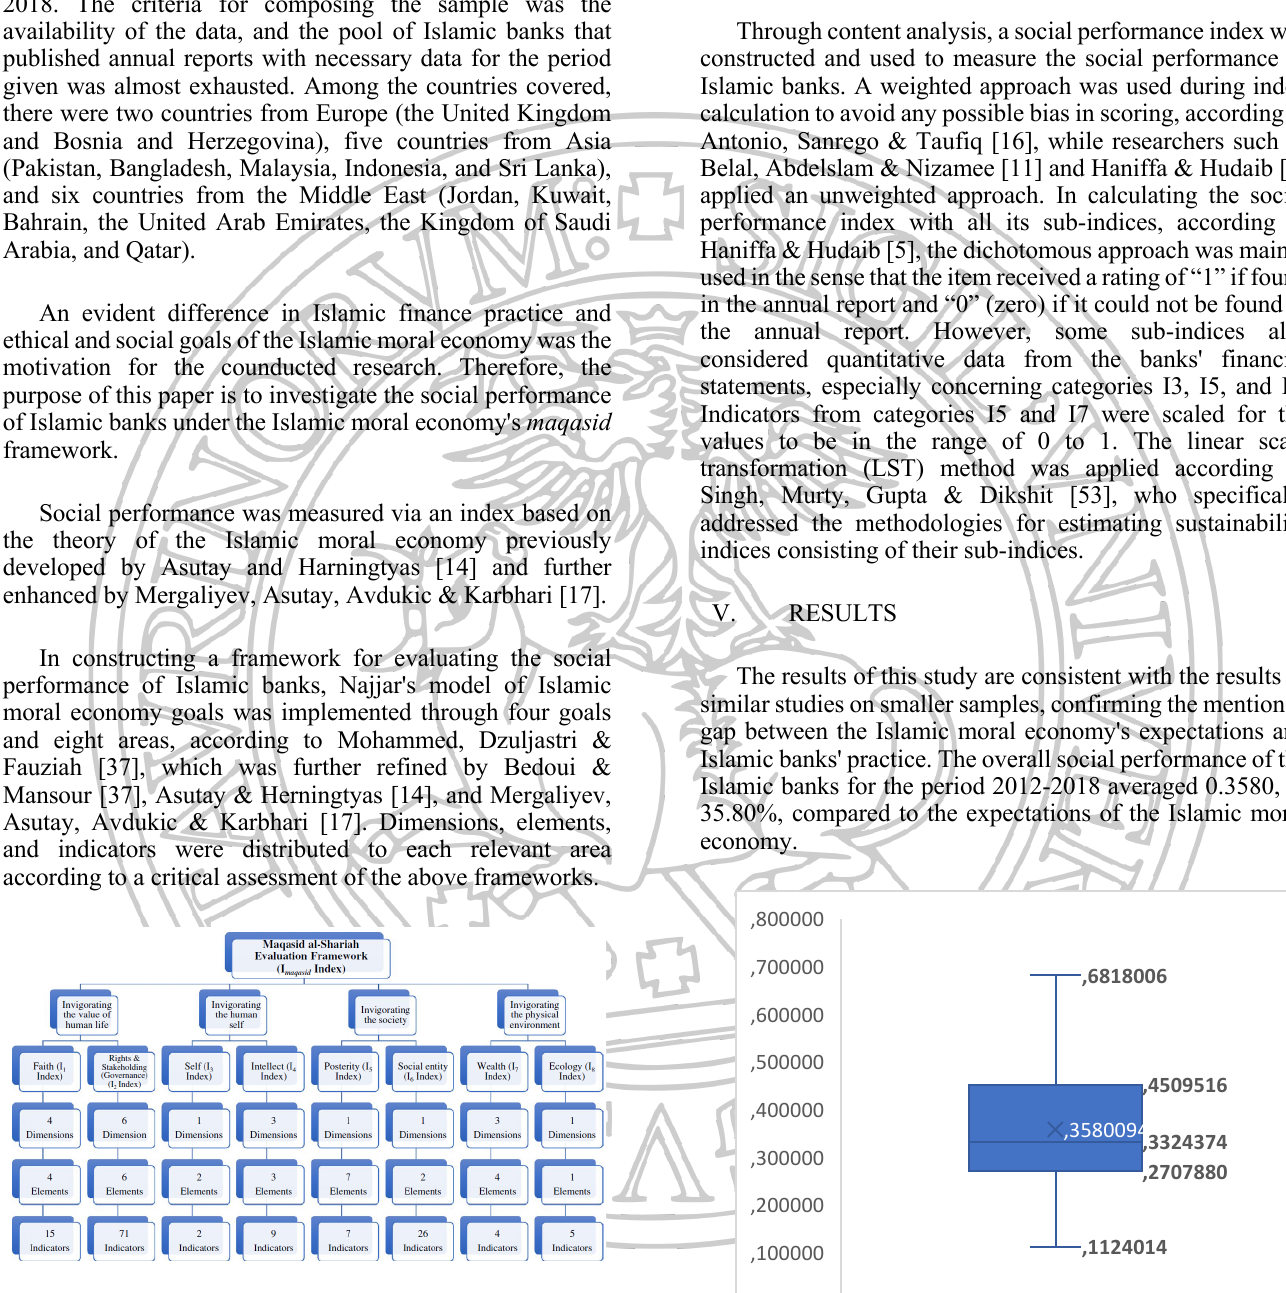
Figure 1. Maqasid evaluation framework